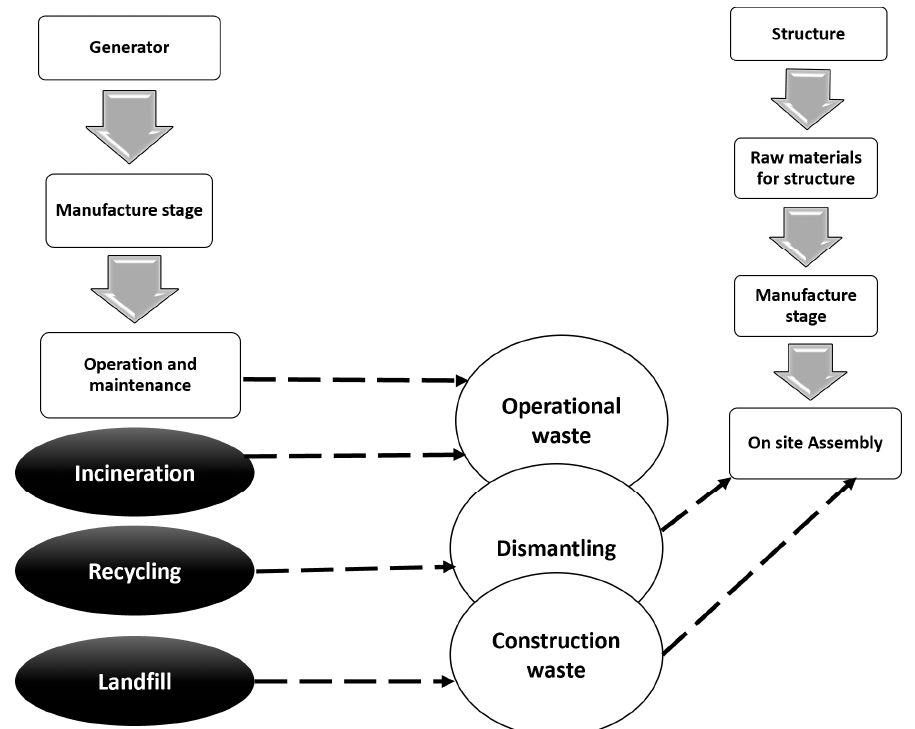
Figure 24. Fundamental LCA model for the generator and overall structure of a wind turbine showing wastes and corresponding disposal/recycling solutions [201].